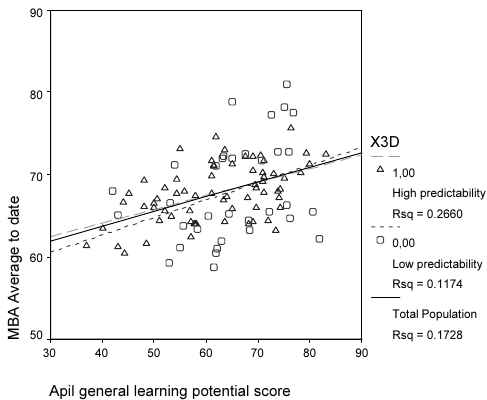
Figure 4: MBA average performance as a function of learning potential depicted for high (X 3 D=1) and low predictability (X 3 D=0) groups separately (predictability index based on real